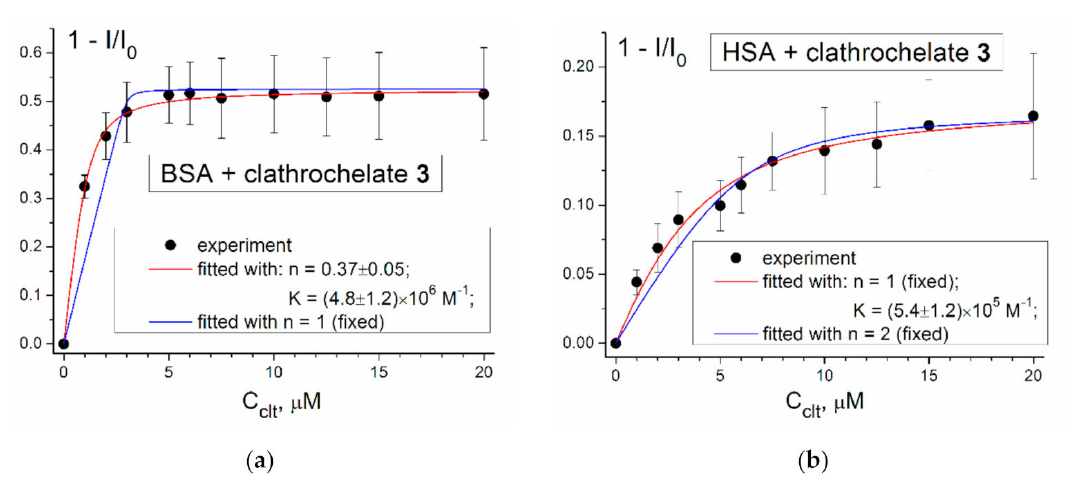
Figure 4. The plots of (1 − I / I 0 ) vs. the concentration of the clathrochelate (C clt ) for a titration of 3 µ M of bovine (BSA; ( a )) and human (HSA; ( b )) serum albumin with the clathrochelate 3 , and the fit of these plots with the equation (2); I and I 0 are protein fluorescence intensities in the presence and in the absence of 3 respectively. Tris–HCl bu ff er (0.05 M) with pH 7.9 was used as a solvent. Experiment performed three times, average values of (1 − I / I 0 ) are presented; error bars correspond to standard deviation of the mean with confidence level of 0.9. Binding constant (K) value is found as the parameter of fitting; number of binding sites per globule (n) value is fixed where mentioned (see the corresponding legends) or found as the parameter of fitting